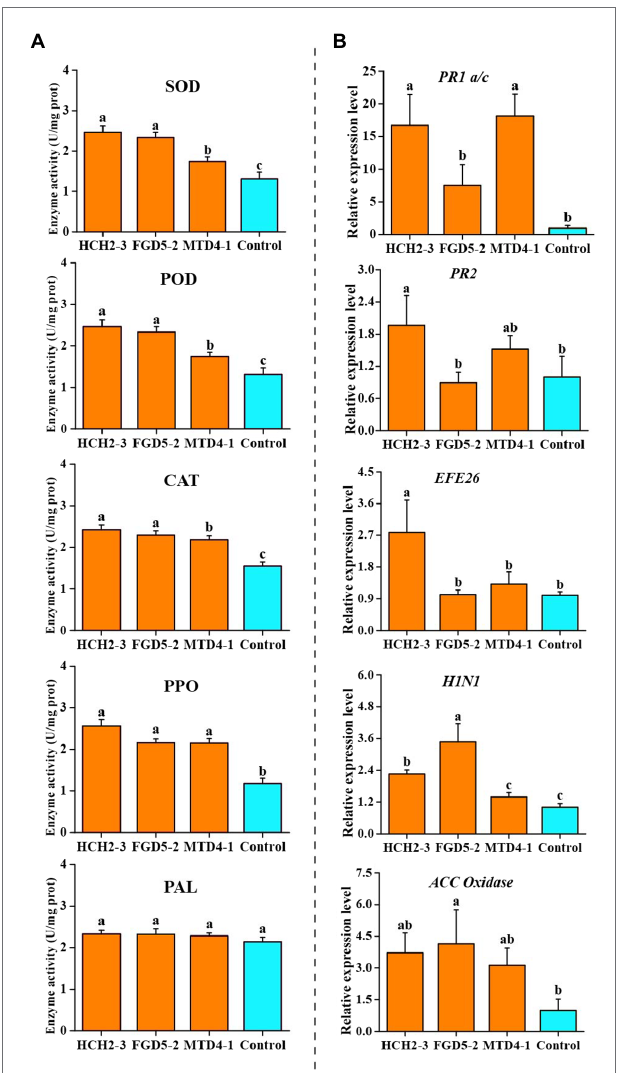
FIGURE 4 | Defense-related enzymes activity (A) and relative expression levels of defense signaling marker genes (B) in the leaves of tobacco plants. Values were analyzed and expressed as mean ± standard error ( n = 6) based on duplicate experiments. The different letters above the bars indicated there were significantly different ( p < 0.05). HCH2-3, P. koreensis ; FGD5-2, P. lurida ; and MTD4-1, P. rhodesiae .